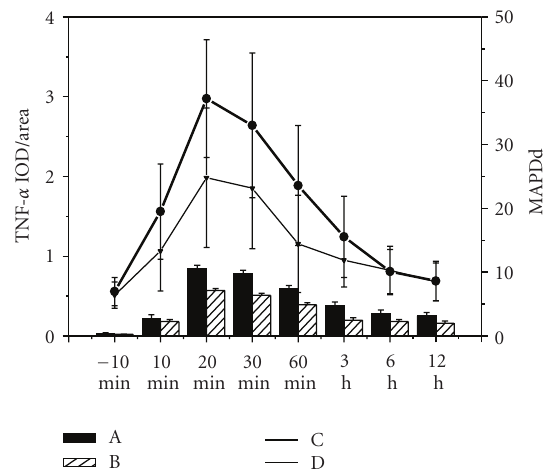
Figure 7: The relationship between TNF- α expression and MAPDds of the border zone. A: Expression of TNF- α in AMI group; B: expression of TNF- α in rhTNFR:Fc group; C: MAPDds of the border zone in AMI group; D: MAPDds of the border zone in rhTNFR:Fc